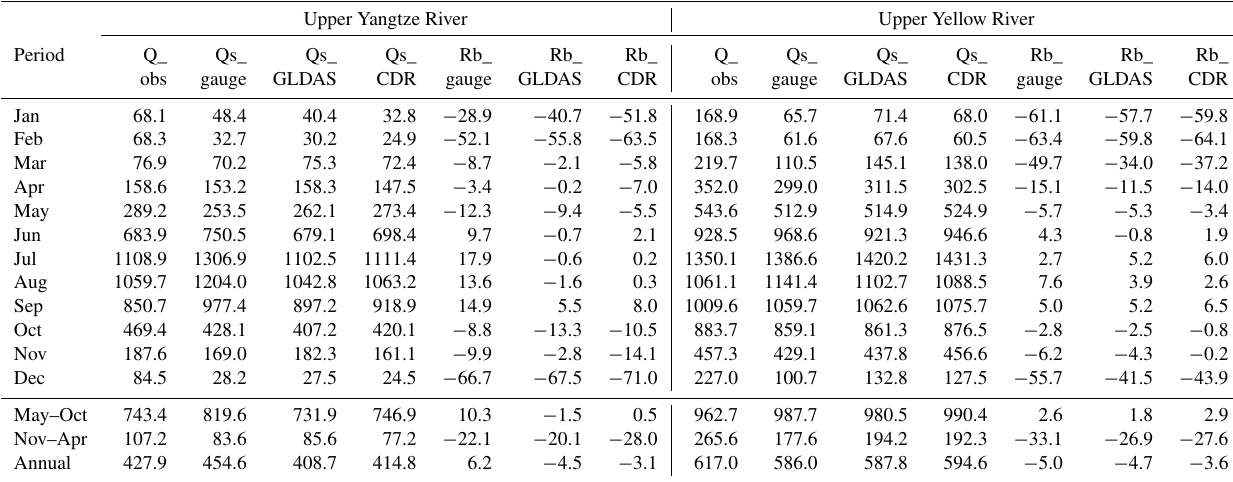
Figure 4. The calculated CDF of daily gauge-based precipitation, GLDAS precipitation, and PERSIANN-CDR precipitation in the upper Yangtze River basin and upper Yellow River basin. Table 4. The performances of streamflow simulations driven by gauge-based precipitation, GLDAS precipitation, and PERSIANN-CDR precipitation in the two